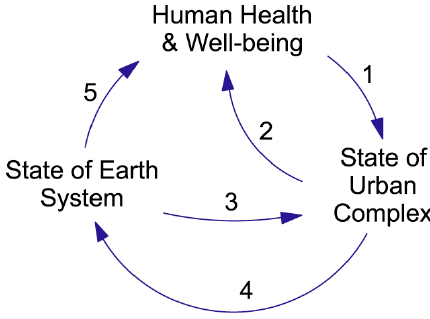
Figure 4. The Co-Effects Template. The blocks of text in this influence diagram represent system stocks (state variables) grouped into three high-level sub-systems. Examples of these stocks are given in Table 1. The arrows represent bundles of causal links. Examples of the flows (state-change processes) associated with each link are given in Table 2.